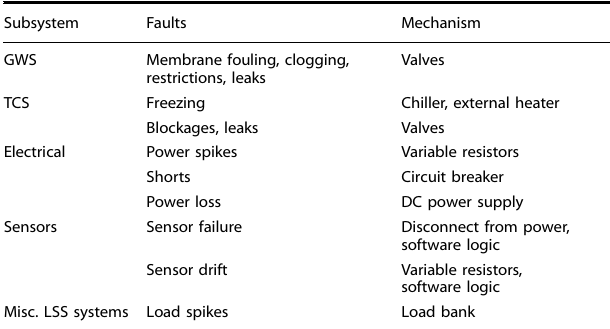
Table 1. Identi fi ed faults through the failure modes and effects analysis and their associated mechanisms where the ReLAA can affect change in the experimental setup with its